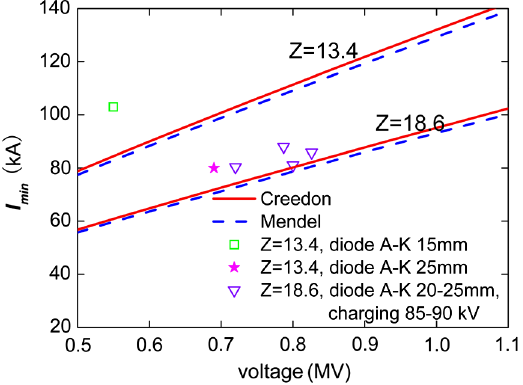
FIG. 7. V - I min curves and discrete experimental states for the two line impedances. Red solid lines denote Creedon’s theory, and blue dashed lines denote Mendel’s theory. The hollow green square represents a magnetically insulated state with Z ¼ 13 : 4 (cid:1) and diode A-K of 15 mm. The solid magenta pentagram represents an unmagnetically insulated state with Z ¼ 13 : 4 (cid:1) and diode A-K of 25 mm. The purple triangles denote experimental state with Z ¼ 13 : 4 (cid:1) , diode A-K 20–25 mm, and charging 85–90 kV. These states are magnetically